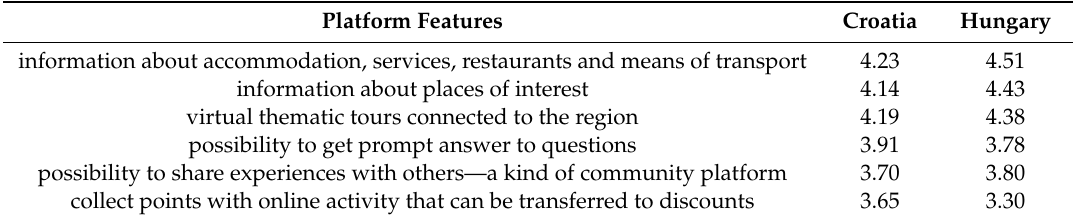
Table 15. Evaluation of an envisioned cross-border information platform in a 1–5 Likert